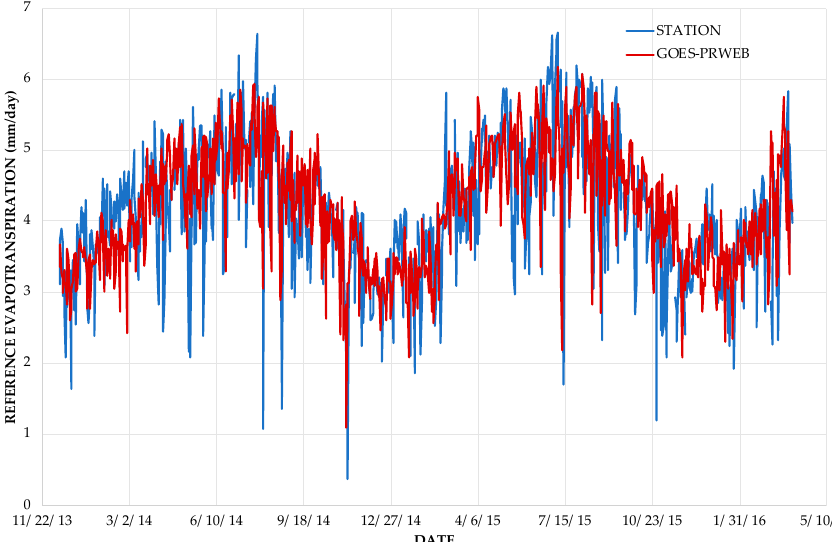
Figure 2. Modeled and observed daily ET o from January 2014 to April 2016 at the UPR Agricultural Experimental Station near Juan Diaz, Puerto Rico.